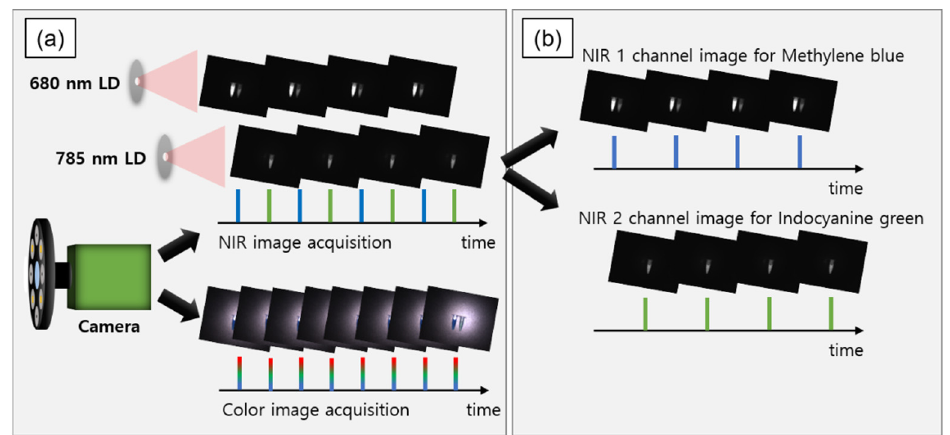
Figure 3. Data acquisition sequence during dual-channel NIR fluorescence imaging: ( a ) color and NIR image acquisition by the camera, with NIR images being sequentially acquired under different LDs; ( b ) division of NIR images into two channels according to the illumination by the two LDs.